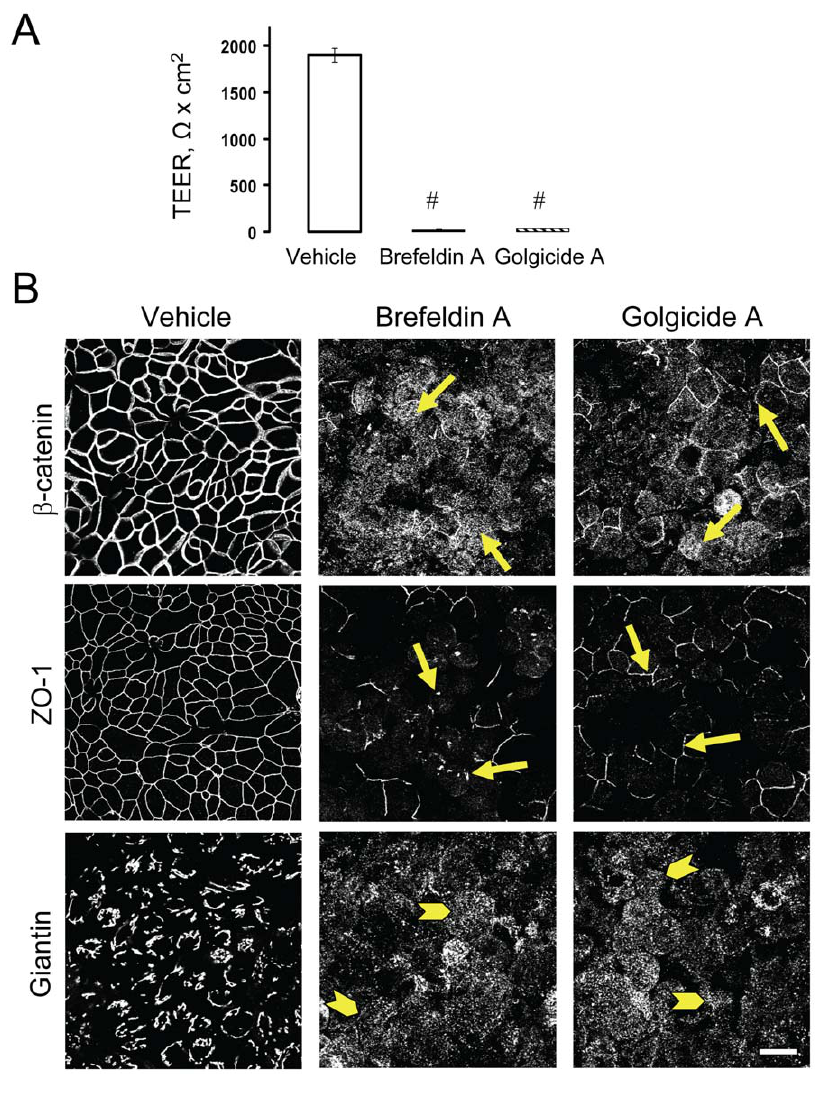
Figure 8. Pharmacological fragmentation of the Golgi induces disruption of the epithelial barrier and disassembly of apical junctions. Immunofluorescence labeling shows that 24 h incubation of SK-CO15 cells with either Brefeldin A (2 m M) or Golgicide A (50 m M) causes a significant increase in paracellular permeability ( A ), dramatic disassembly of AJs and TJs ( B, arrows ), and fragmentation of the Golgi ( B, arrowheads ); # p , 0.01 compared to the vehicle-treated group (n=3). Scale bar, 20 m